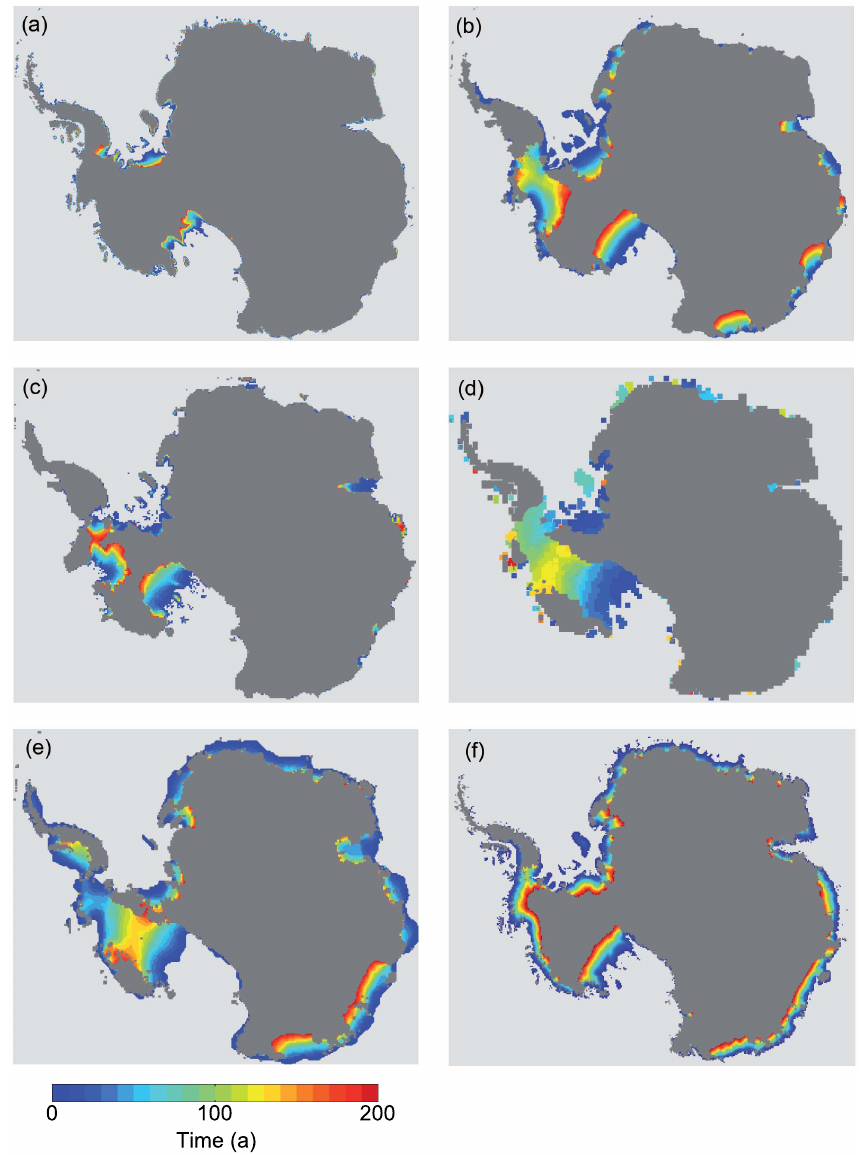
Figure 2. Evolution of the Antarctic grounded area as computed by the five models which participated in the SeaRISE experiment M3 (a–e) and similar results obtained by SISM (f) . Colors correspond to the time of